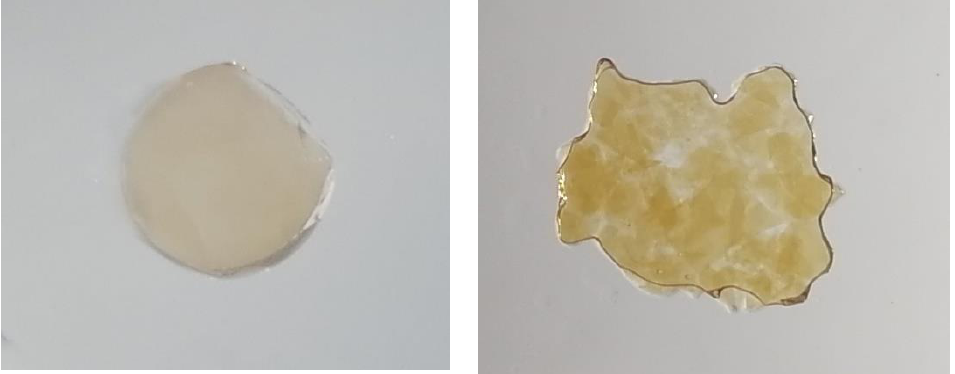
Figure 7. Examples of homogeneous gel ( left image with a DM~0, APP-E) and inhomogeneous gel ( right image with a DM~59%, APP-Ca 2+ ). Sizes of the samples were around 10 mm in diameter.